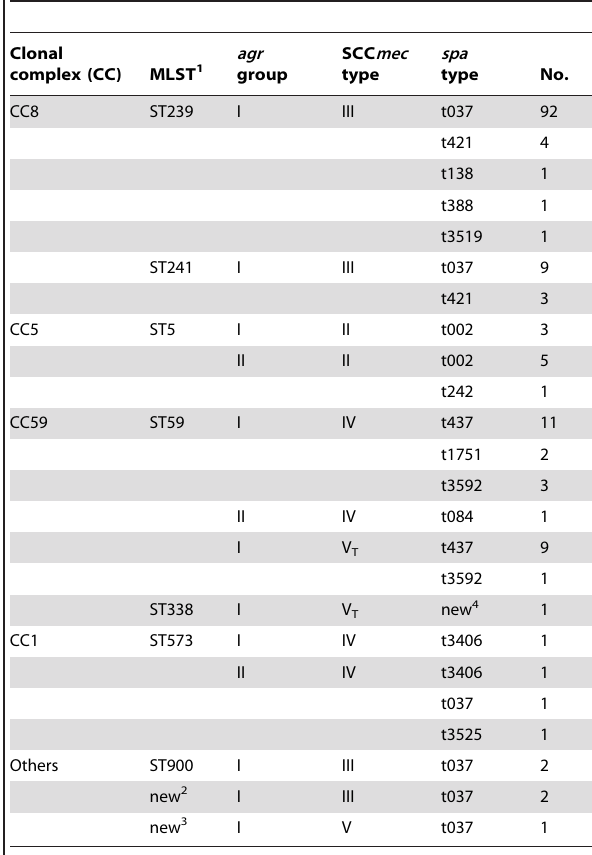
Table 2. Clonal complexes and relationship between various molecular types of 157 MRSA blood